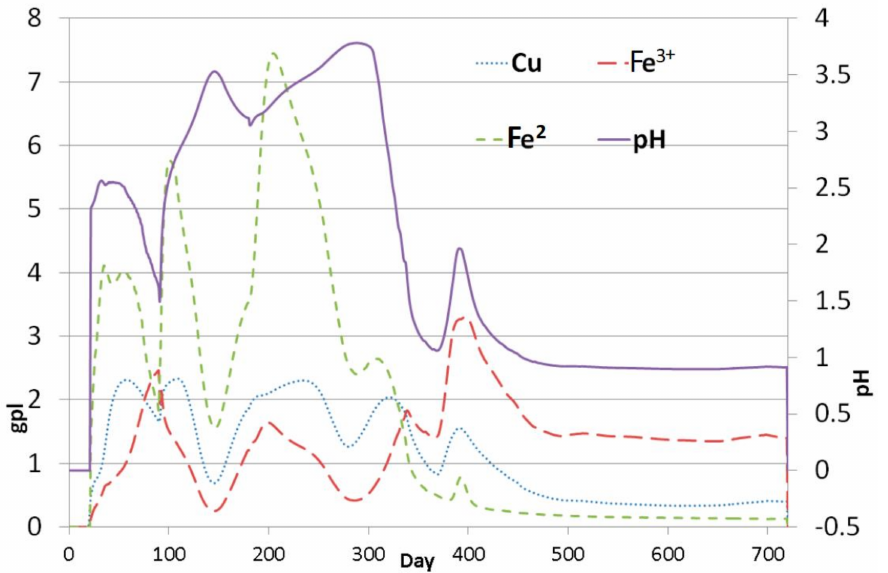
Figure 9. Composition of recovered solution for intermittent leach.